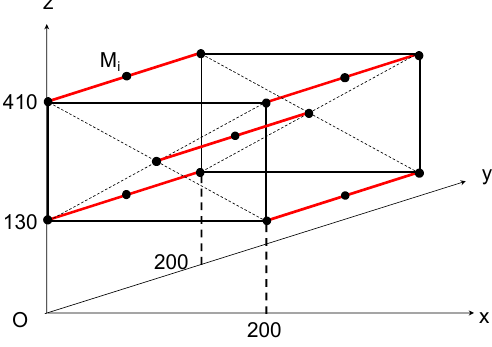
Figure 7. Laser interferometer (LI) measurement.